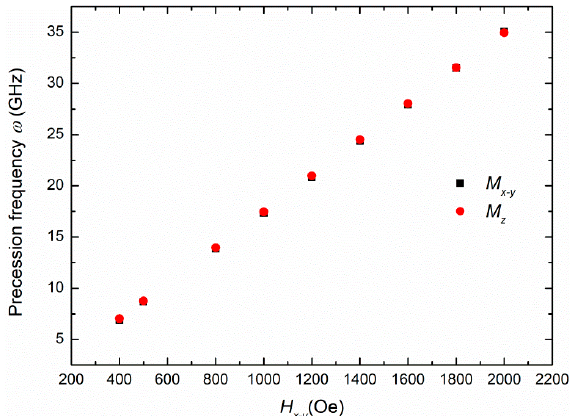
Figure 4. (Color online) Precession frequency simulated by LLG equation as a function the in-plane magnetic anisotropy field H x-y for annealed compressively-strained (Ga,Mn)As film.